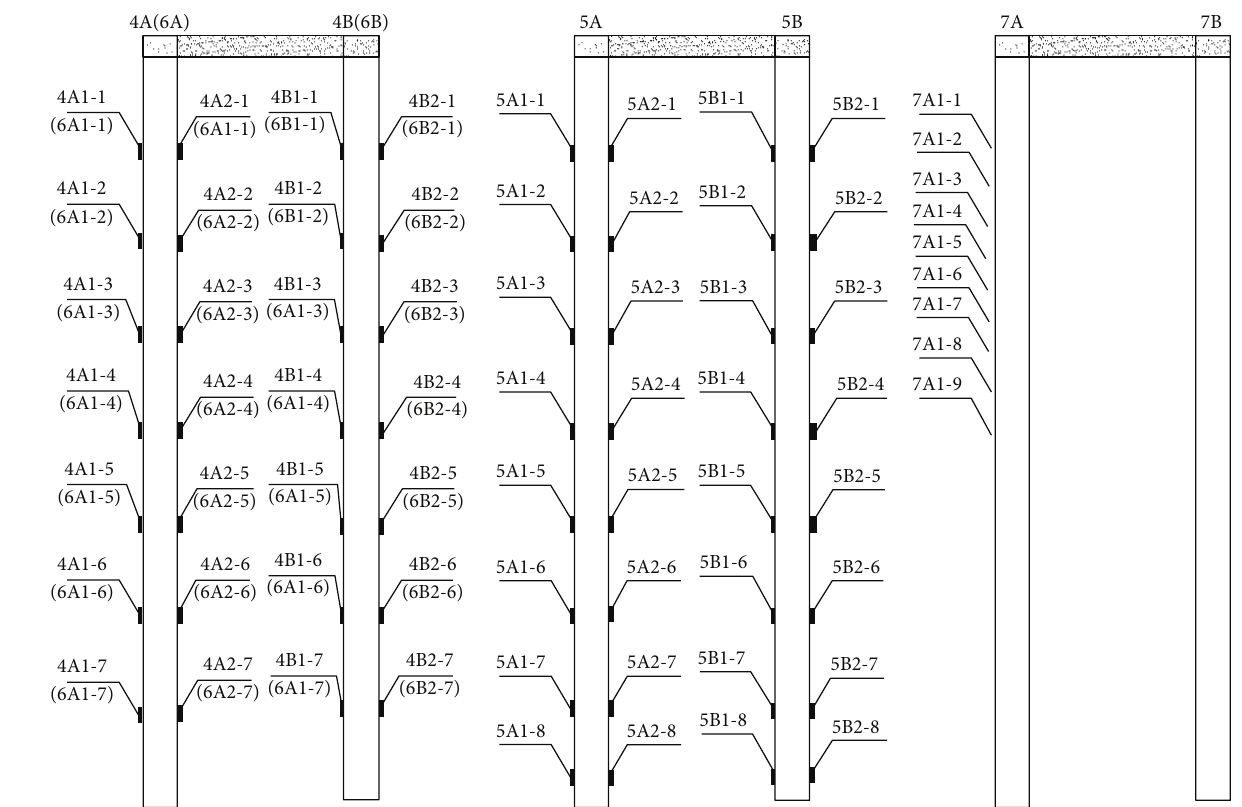
Figure 5: Location of strain gauge and dial gauge and earth pressure